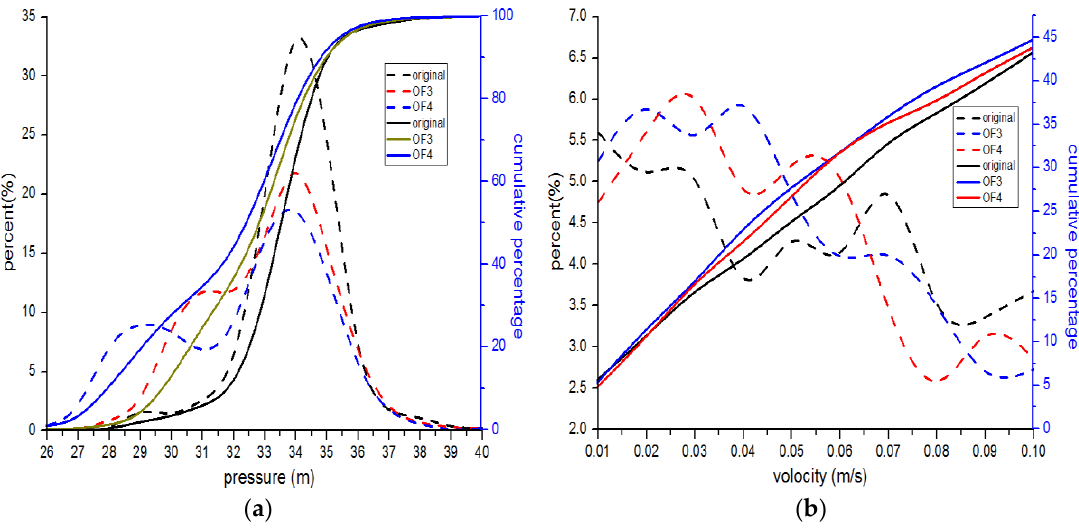
Table 6. The excluded 8 pipes by preliminary hydraulic analysis.